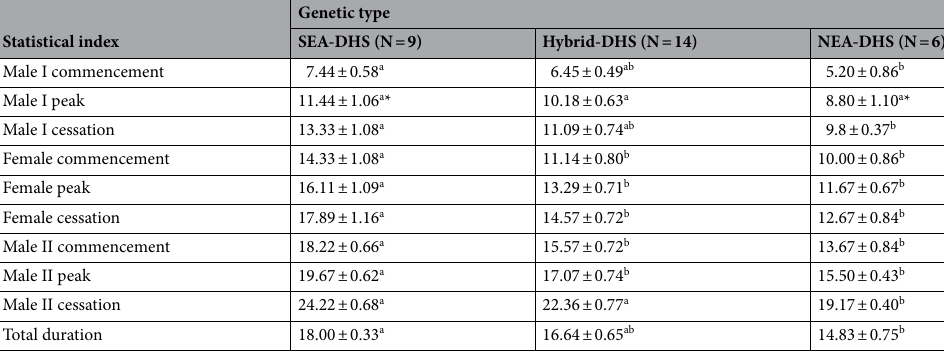
Table 1. Flowering phenology of SEA-DHS, Hybrid-DHS, and NEA-DHS. Observations commenced on April 20th. Significant differences between pairs determined at the p < 0.05 level based a one-way ANOVA were indicated by different superscript letters. a*: p = 0.06. SEA-DHS Southern East Asia lineage of the Acer species complex in the Daheishan National Nature Reserve (DHS), NEA-DHS Northern East Asia lineage of the Acer species complex in the DHS, Hybrid-DHS hybrids between SEA-DHS and NEA-DHS